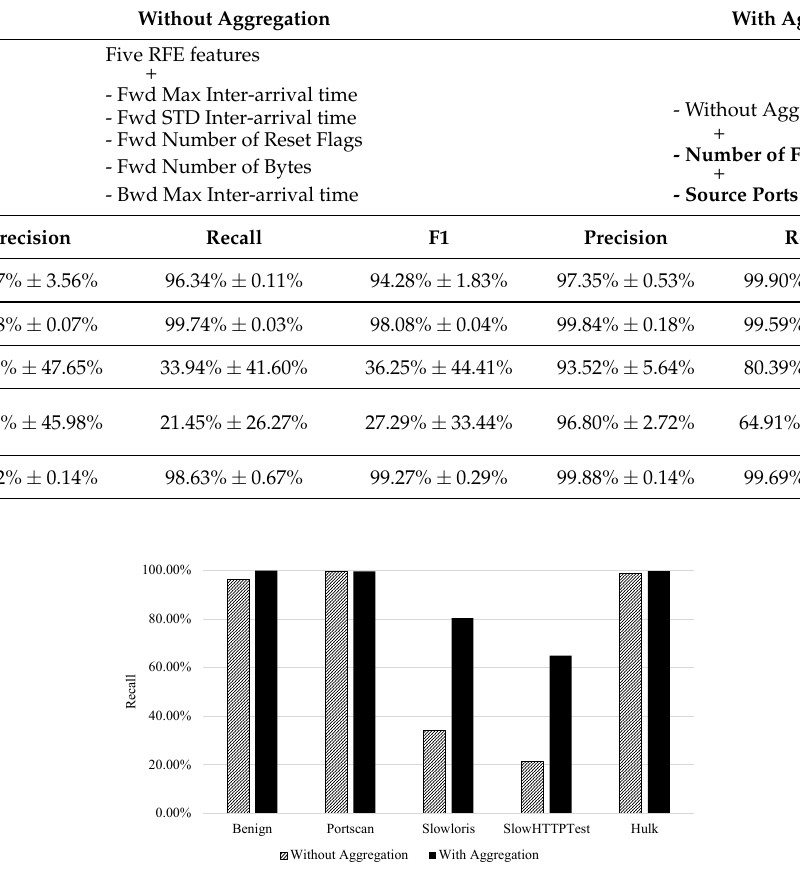
Table 12. Five classes classification (5-fold cross validation).